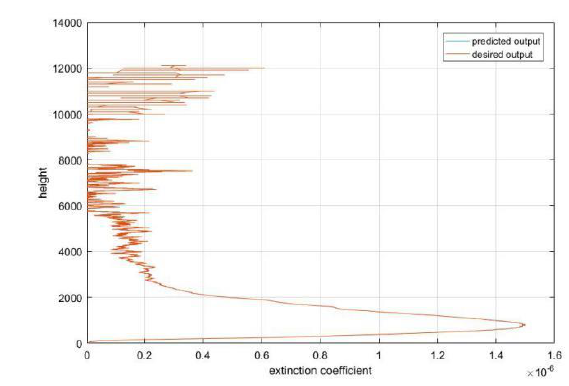
Figure 8. Prediction of extinction coefficient under cloudless